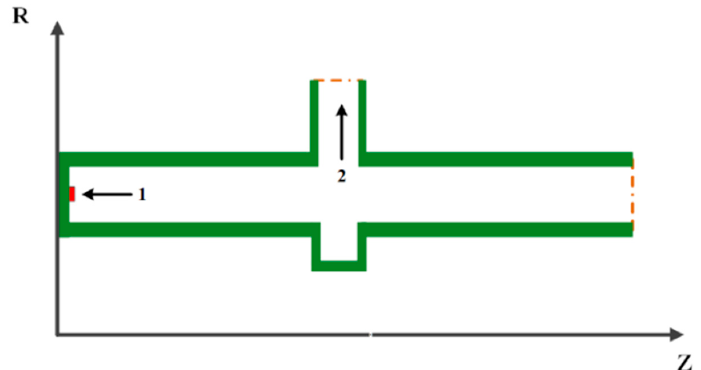
Figure 2. The modulation model of input cavity: 1—cathode, 2—input cavity.